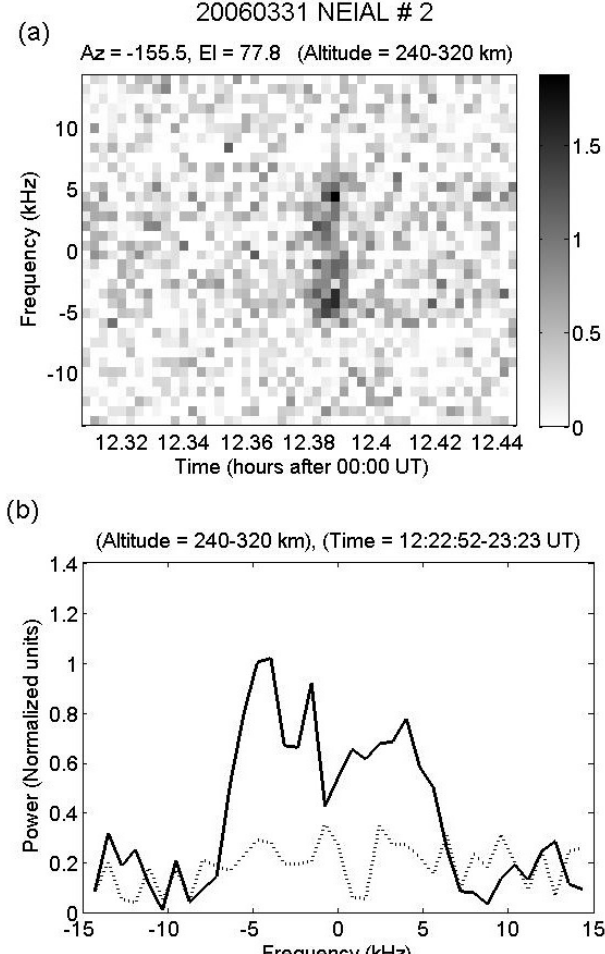
Fig. 4. The spectra of NEIAL #2. (a) Power versus frequency and time, averaged over the altitude range in which the NEIAL occurs. (b) Line plot showing the power versus frequency averaged over the altitude and time of the NEIAL. The dotted line on (b) is the background level taken from a similar time interval within a minute of the NEIAL